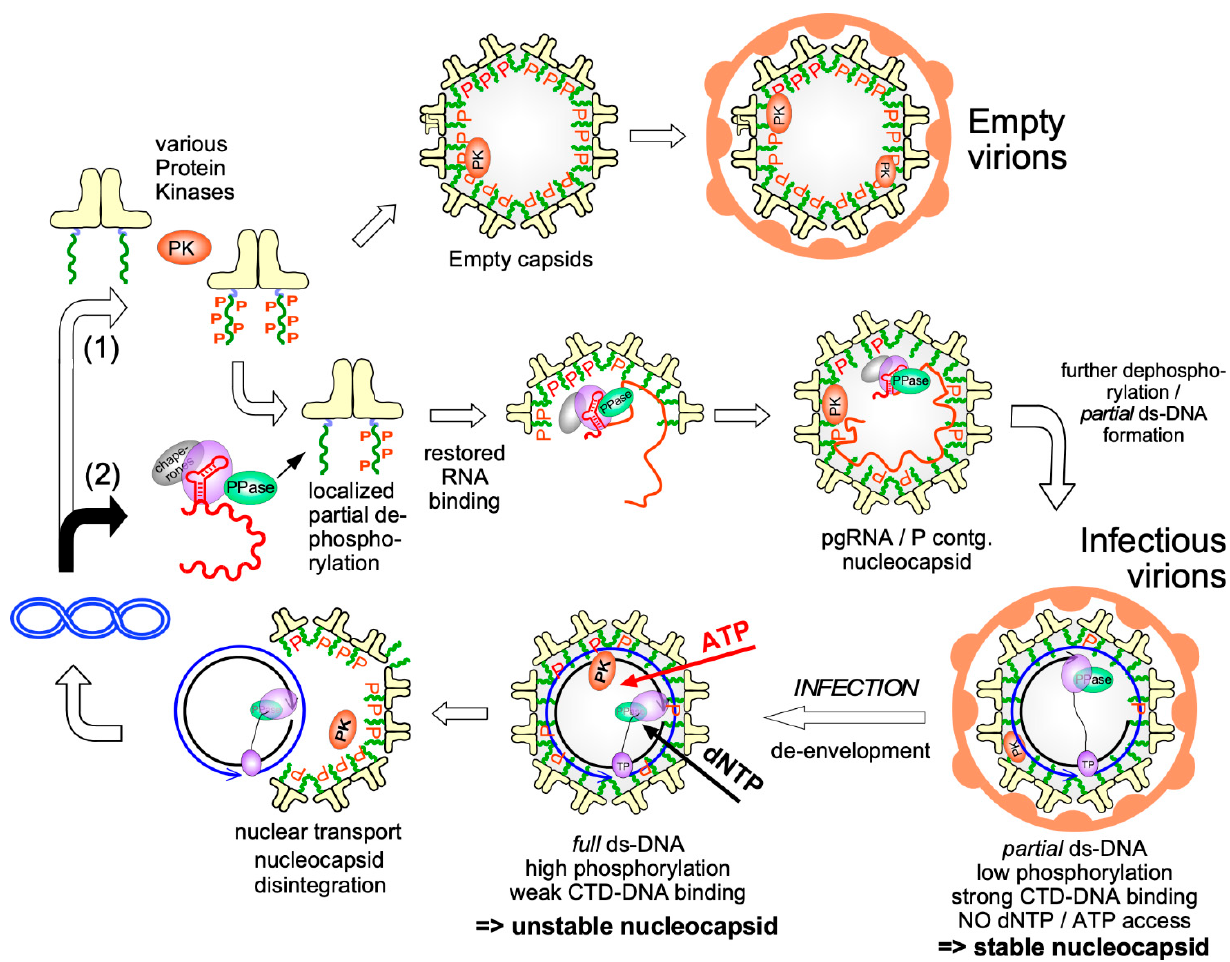
Figure 6. A model correlating HBV Cp phosphorylation and replication dynamics. By default, Cp produced in hepatocytes (1) is a substrate for various protein kinases (PKs), causing high-level phosphorylation, suppression of nucleic binding capacity and eventually empty virion formation; this prevents packaging of non-relevant viral and cellular RNAs. For infectious virion production (2) the model predicts that specific encapsidation of the pgRNA-P complex is enabled by the localized dephosphorylation of nearby Cp dimers by (a) protein phosphatase(s) associated with that complex. This restores the previously suppressed RNA binding capacity of Cp, with dephosphorylation of further Cp subunits enabling interactions that result in progressive and, eventually, complete packaging of pgRNA into newly forming nucle- ocapsids, and, subsequently, infectious virions in which Cp is largely unphosphorylated. The envelope blocks access of ATP and dNTPs. Upon infection of a new cell, removal of the envelope (de-envelopment) allows influx of dNTPs and ATP into the particle, enabling further fill-in of the plus-strand DNA, and re-phosphorylation of previously dephosphorylated Cp subunits. In effect, this increases conformational stress from the increasing DNA stiffness, and reduces Cp’s nucleic acid binding capacity, weakening the nucleocapsid structure. Eventually, this destabilization mediates disintegration of the capsid shell and release of the rcDNA into the nucleus to start of a new